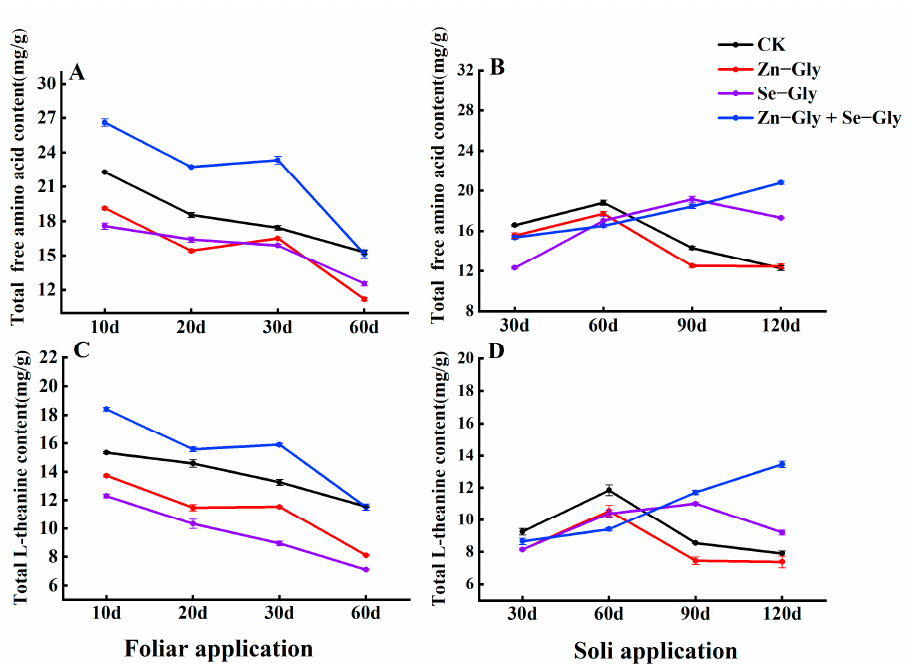
Figure 5. The content of total free amino acids and L − theanine in tea leaves under different fertilization treatments. ( A , C ) Content of total free amino acids and L − theanine in tea leaves following foliar fertilizer application; ( B , D ) Content of total free amino acids and L − theanine in tea leaves following soil fertilizer application. The abscissa shows the days of treatment. Different colors represent different treatments, as follows: black, CK; red, Zn − Gly; purple, Se − Gly; blue, Zn − Gly + Se − Gly.